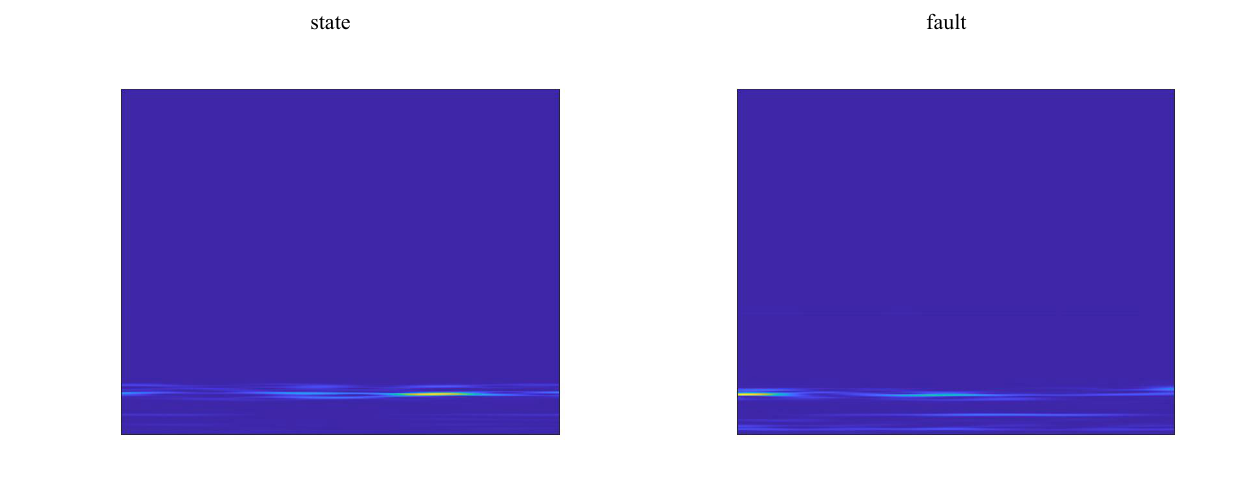
Figure 1. The time–frequency images of a set of samples representing four kinds of state types of